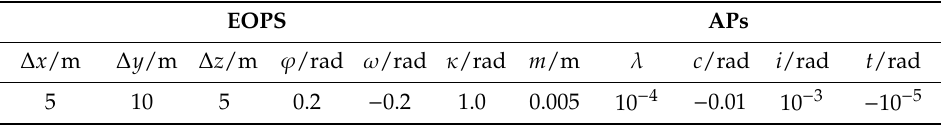
Table 1. True values of EOPs and APs in simulation